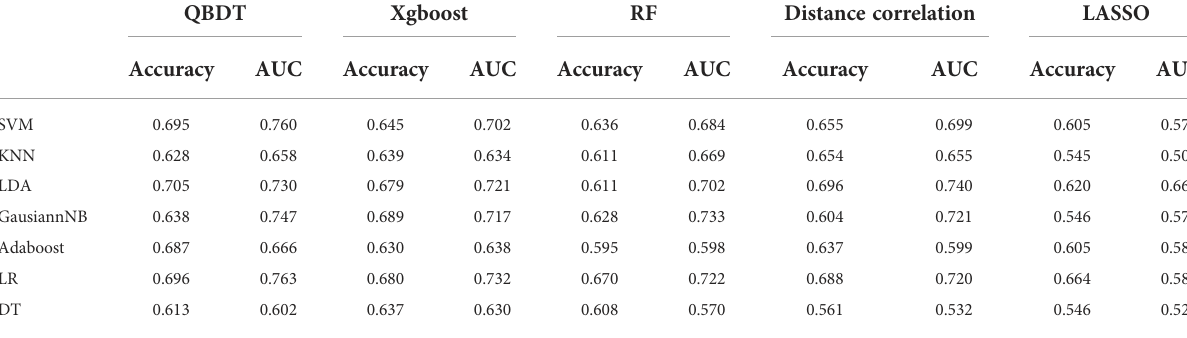
TABLE 4 Results of discriminative RMs in group 2 in the testing